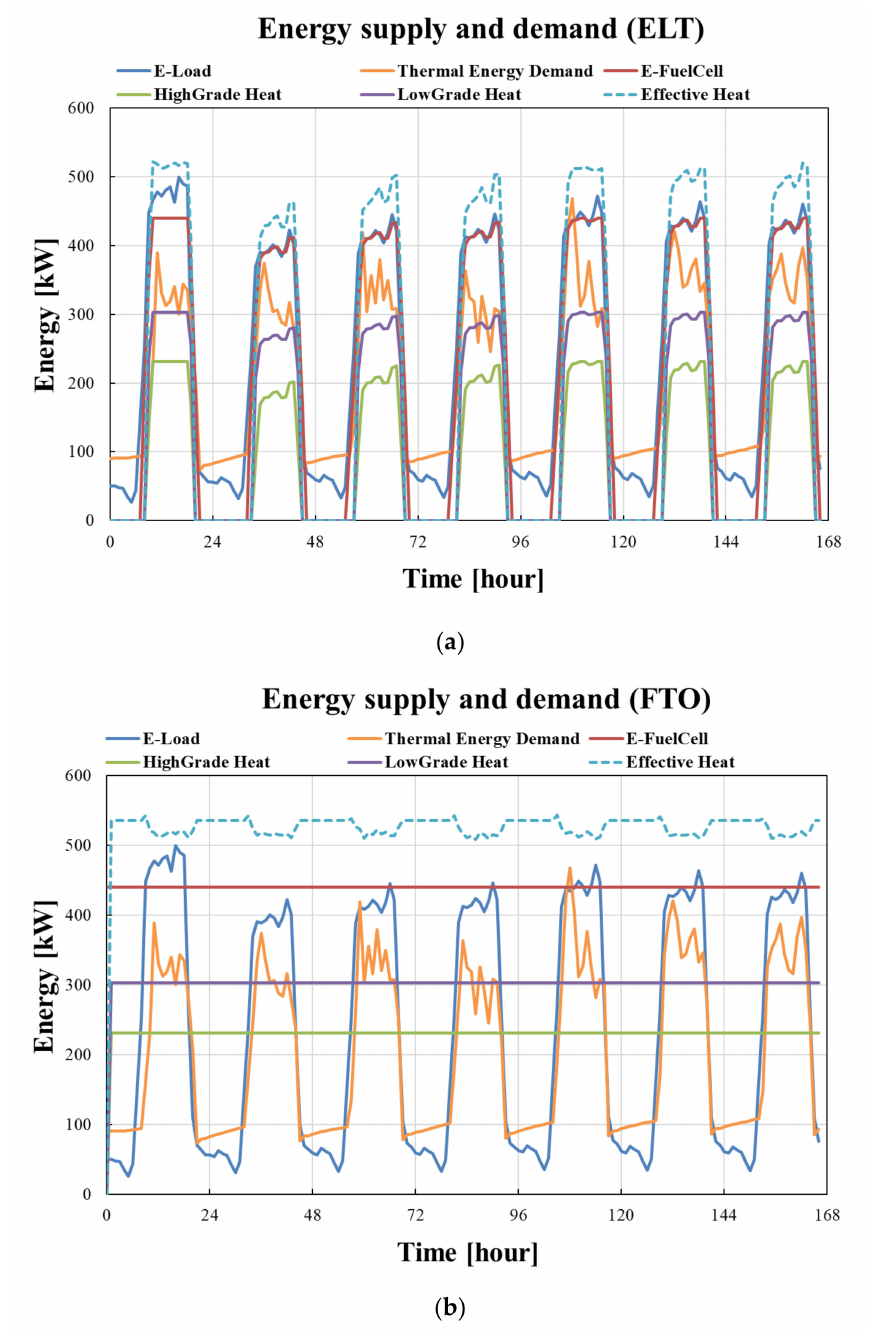
Figure 10. Energy demand and supply of FC-CHP systems for the first week of January (( a ) ELT model; ( b ) FTO